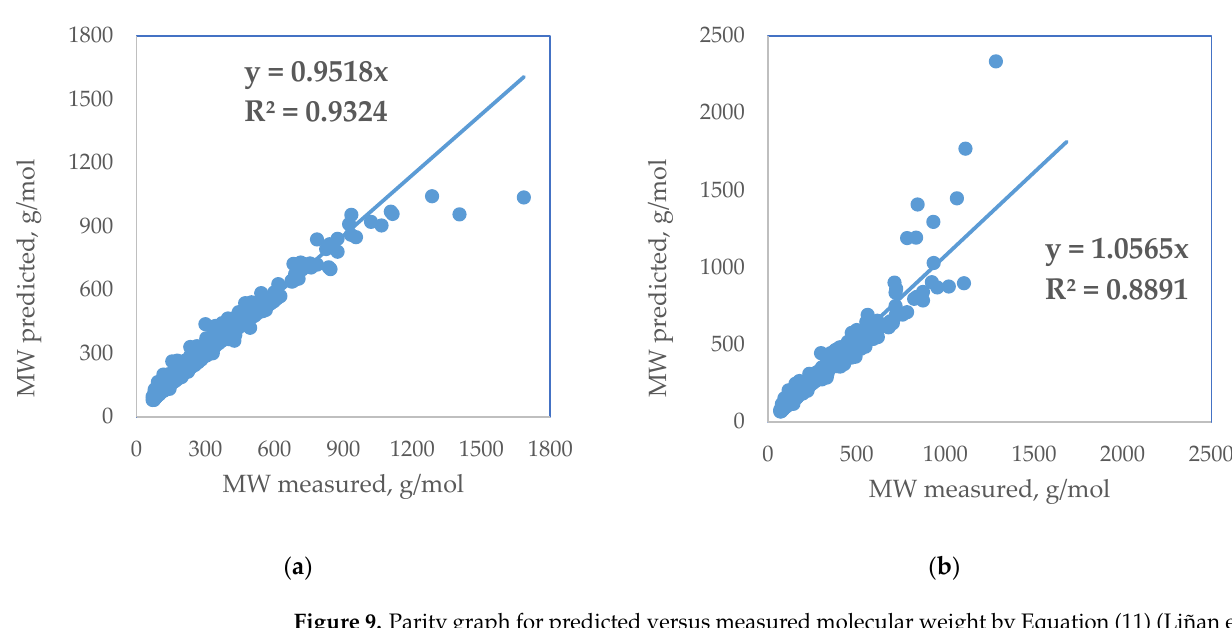
Figure 8. Parity graph for predicted versus measured molecular weight by Equation (2) (Kesler and Lee) ( a ) and by Equation (4) (Twu) ( b ).